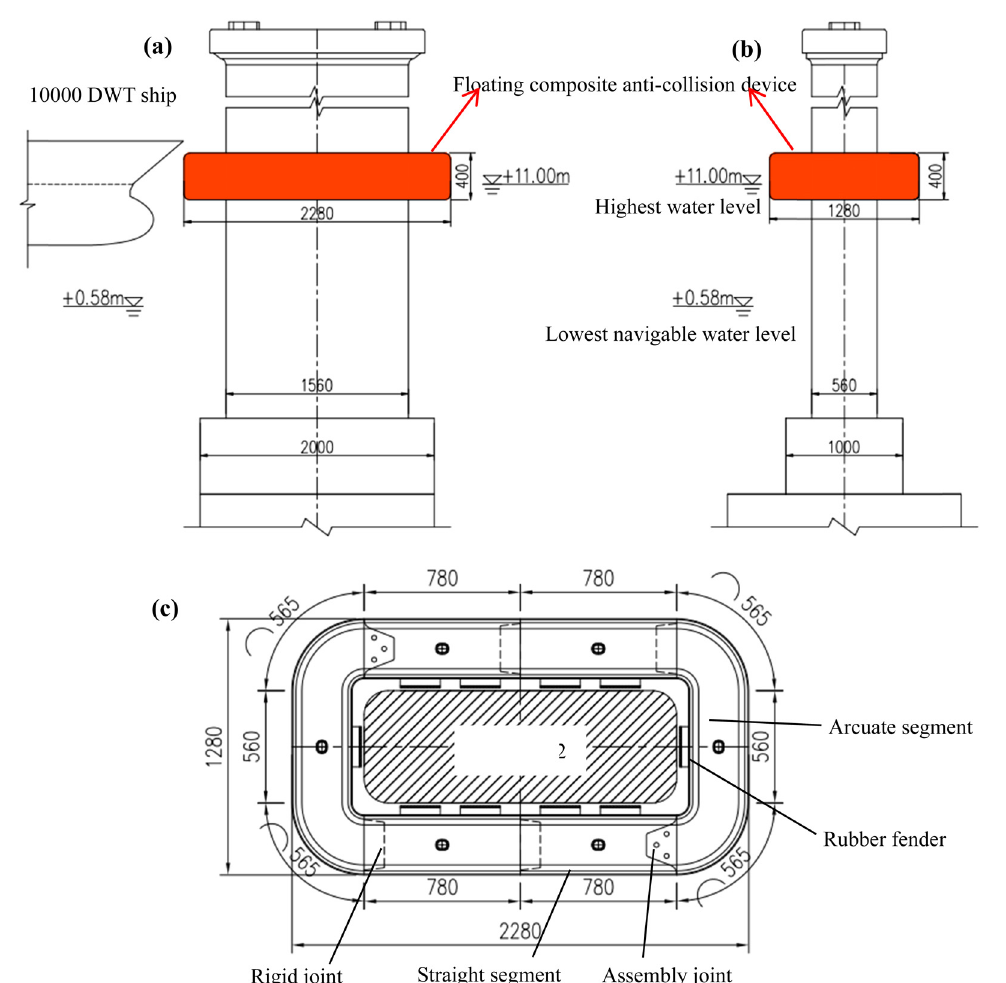
Figure 20: Layout of Pier No. 12 with fl oating composite anti - collision device: ( a ) head - on elevation view, ( b ) side elevation view, ( c ) planar view. ( Note: Except as indicated in the fi gure, the remainder is calculated as cm.